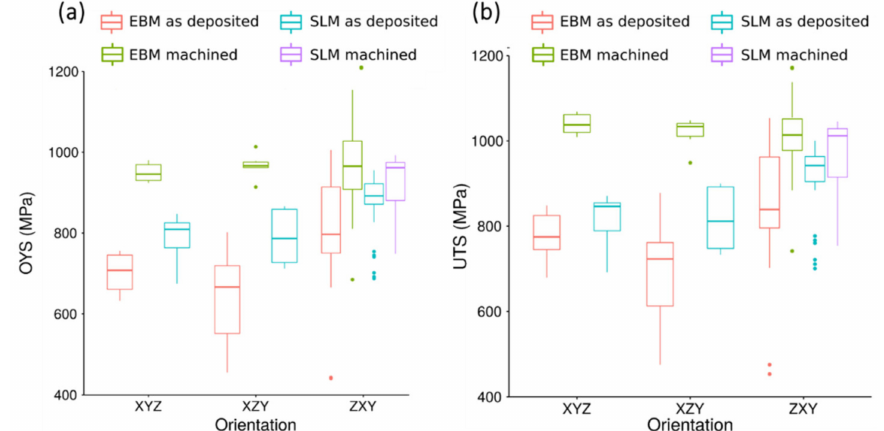
Figure 8. Comparison of average values for as-deposited and machined EBM specimens with di ff erent build orientations: ( a ) OYS, ( b ) UTS. Data for SLM flat specimens from previous work is provided for comparison.